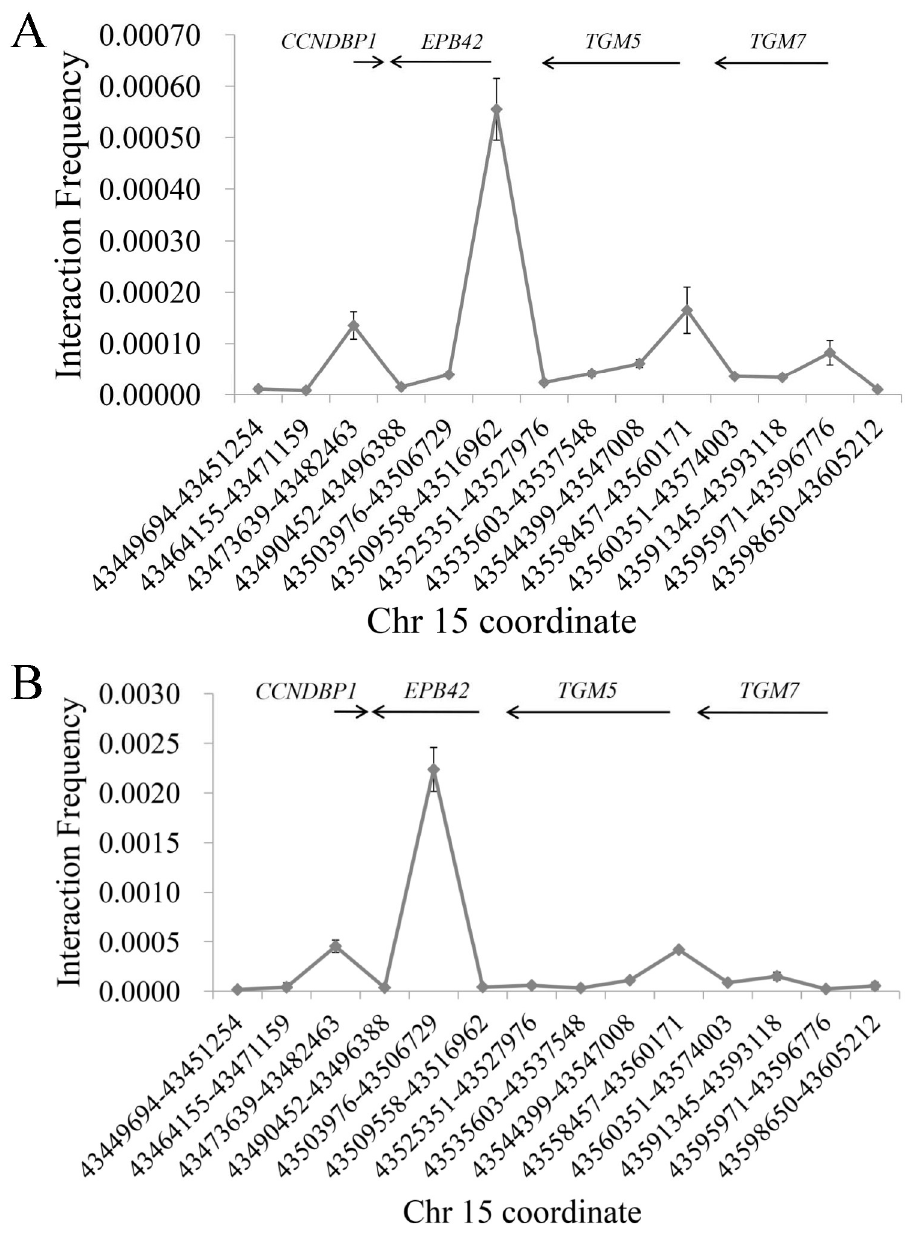
Fig 2. Interaction efficiency in Beas-2B cell between the enhancer containing rs66651343 and rs12909095 (A) or rs17779494 (B) and surrounding genome regions in 15q15.2. The x axis shows the start and end of the restrictive segments in chr15 (relative to human genome build 37) while the y axis indicates the relative interaction efficiency. The above arrow shows the schematic position and transcript direction of the gene in this region. All data is shown as mean ±